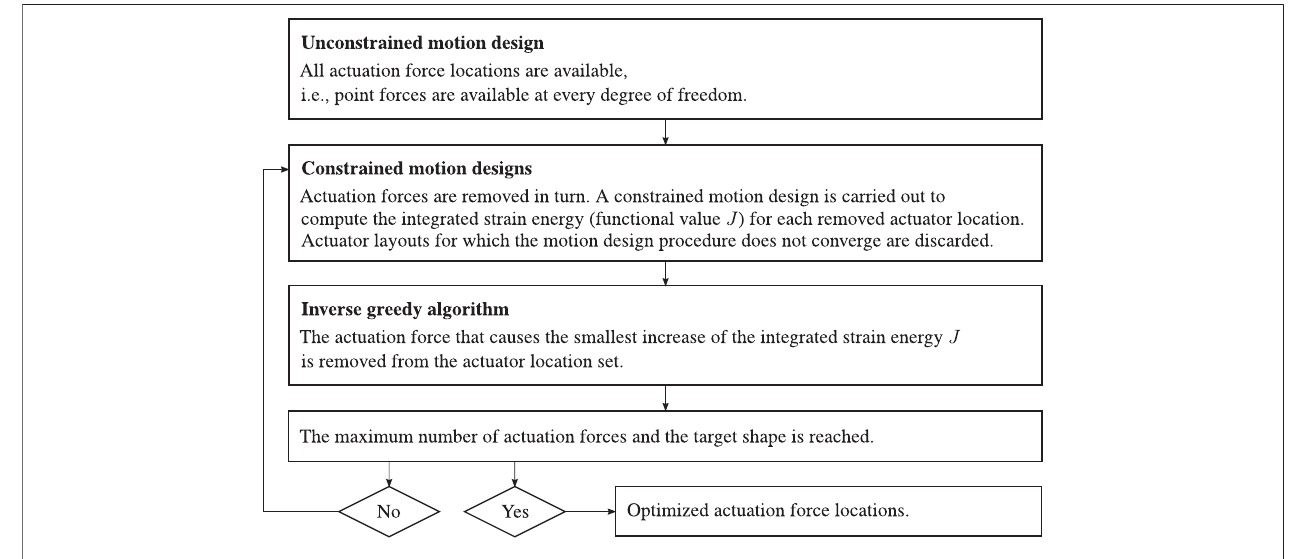
FIGURE 3 | Flowchart of the actuator placement optimization